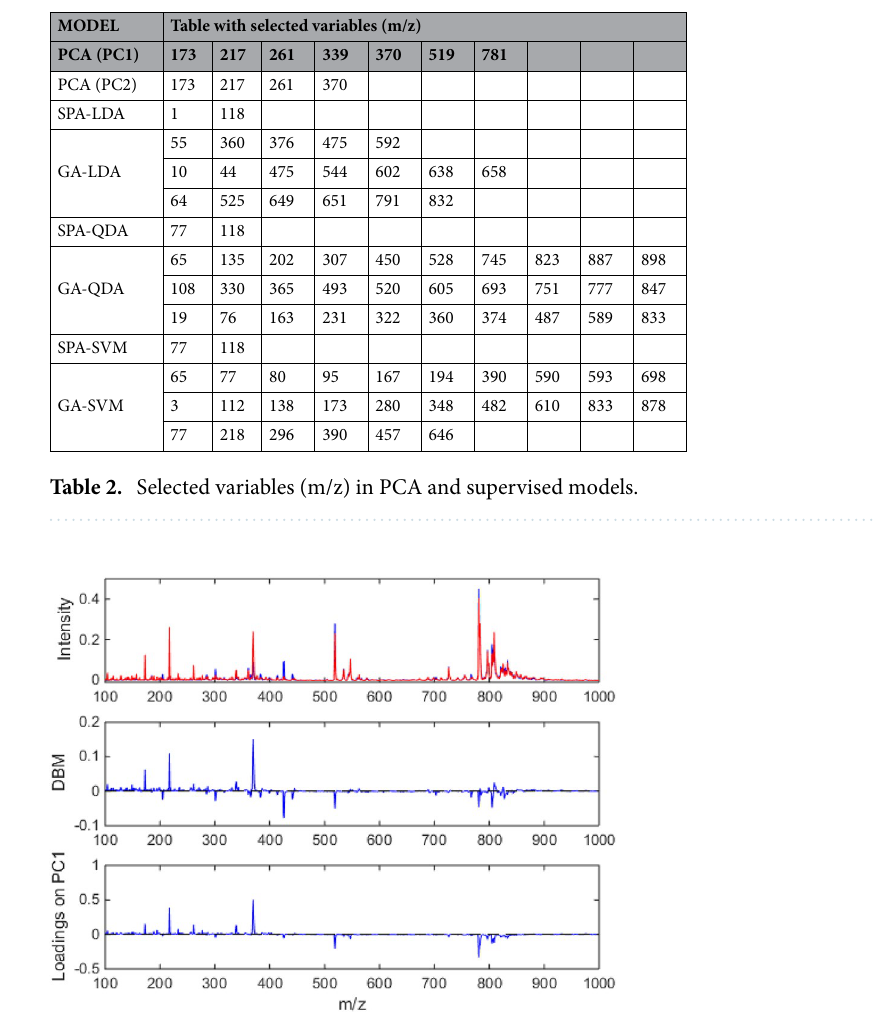
Figure 3. The spectral mean with all samples, the difference between the spectral means (DBM) and the chemical profile of the samples for PC1 are